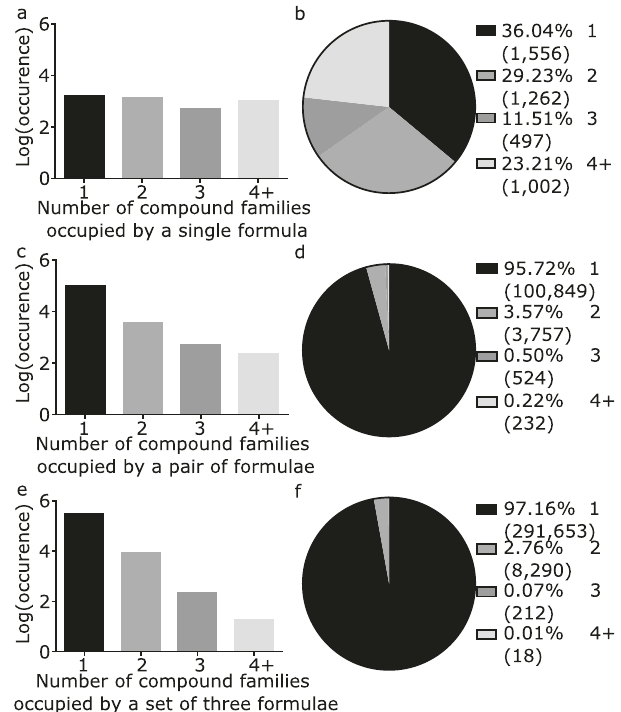
Fig. 1 | Intra-family distributions of molecular formulae. The log-transformed occurrence (bar charts) or proportion (pie charts) of a , b a single molecular for- mula, c , d a pair of molecular formulae, or e , f a set of three molecular formulae appearing in one or more compound families in the Natural Products